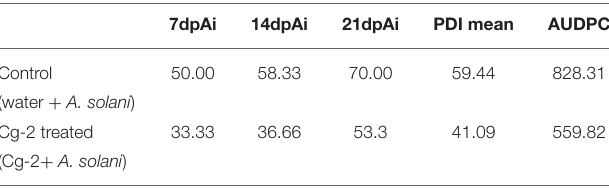
TABLE 1 | The plant disease index (PDI) and the area under disease progress curve (AUDPC) for untreated and treated